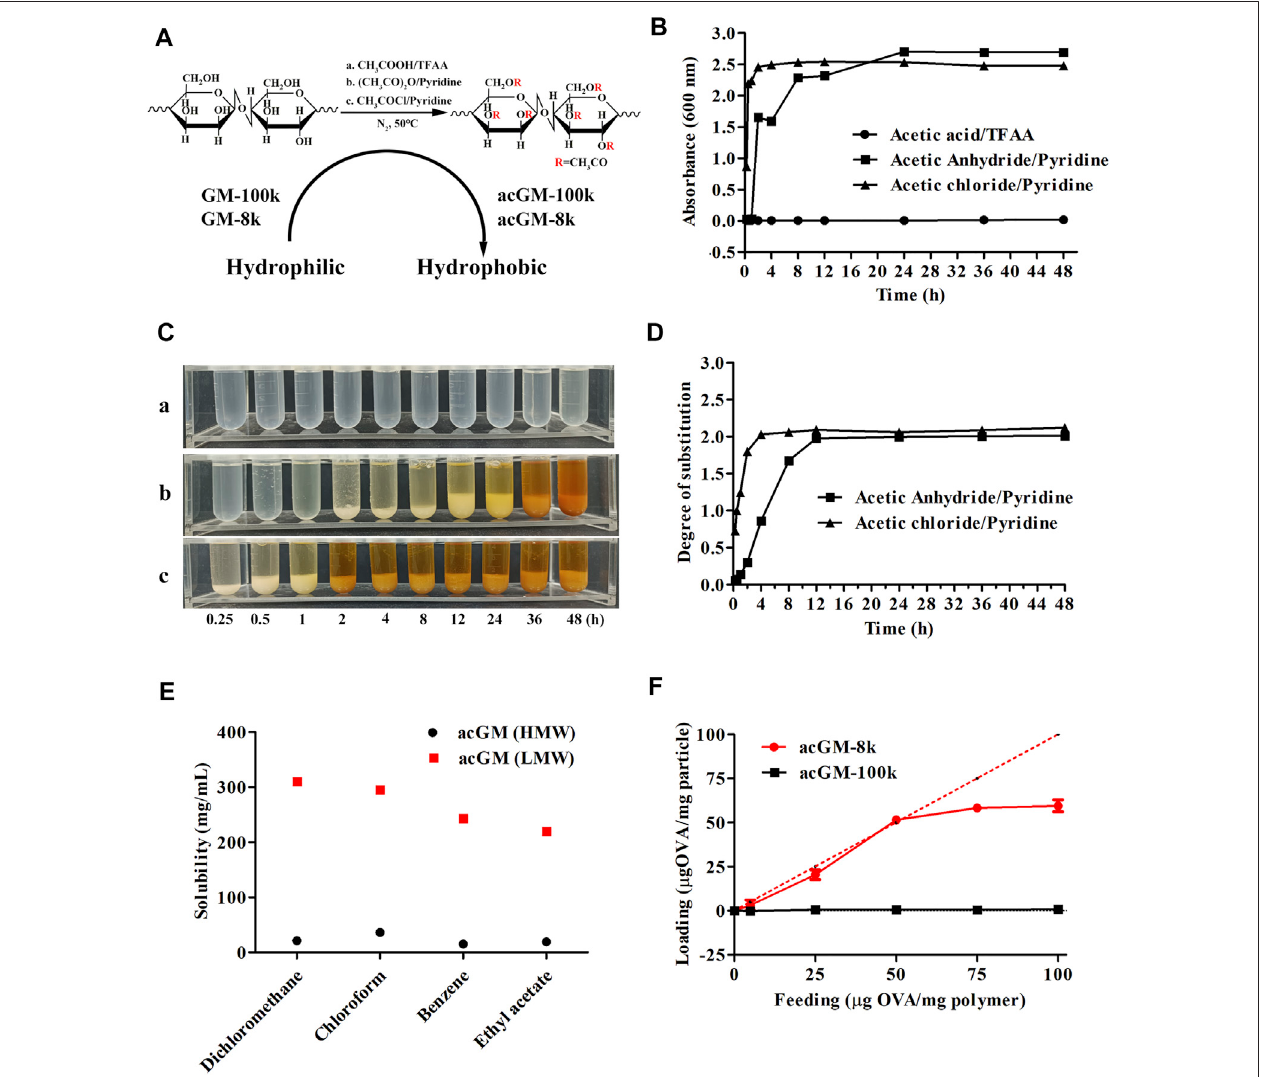
FIGURE2| ScreeningacGMforantigenencapsulation. (A) SchemeofdifferentacetylationmethodstosynthesizeacGM. (B) Turbidityofthemixtureofthereaction solutionanddd-H 2 O(V/V=1:1)atdesignedtimepoints. (C) Themixtureofthereactionsolutionanddd-H 2 O(V/V=1:1)wasprecipitatedovernight.(a)TFAA/aceticacid; (b)Aceticanhydride/pyridine;(c)Aceticchloride/pyridine. (D) Effectofreaction timeonthemeasurementofthedegreeofsubstitution(DS). (E) Effectofmolecularweight on the solubility of acGM with the DS of 1.8 in volatile solvents. (F) Effect of molecular weight on OVA loading capacity and encapsulation ef fi